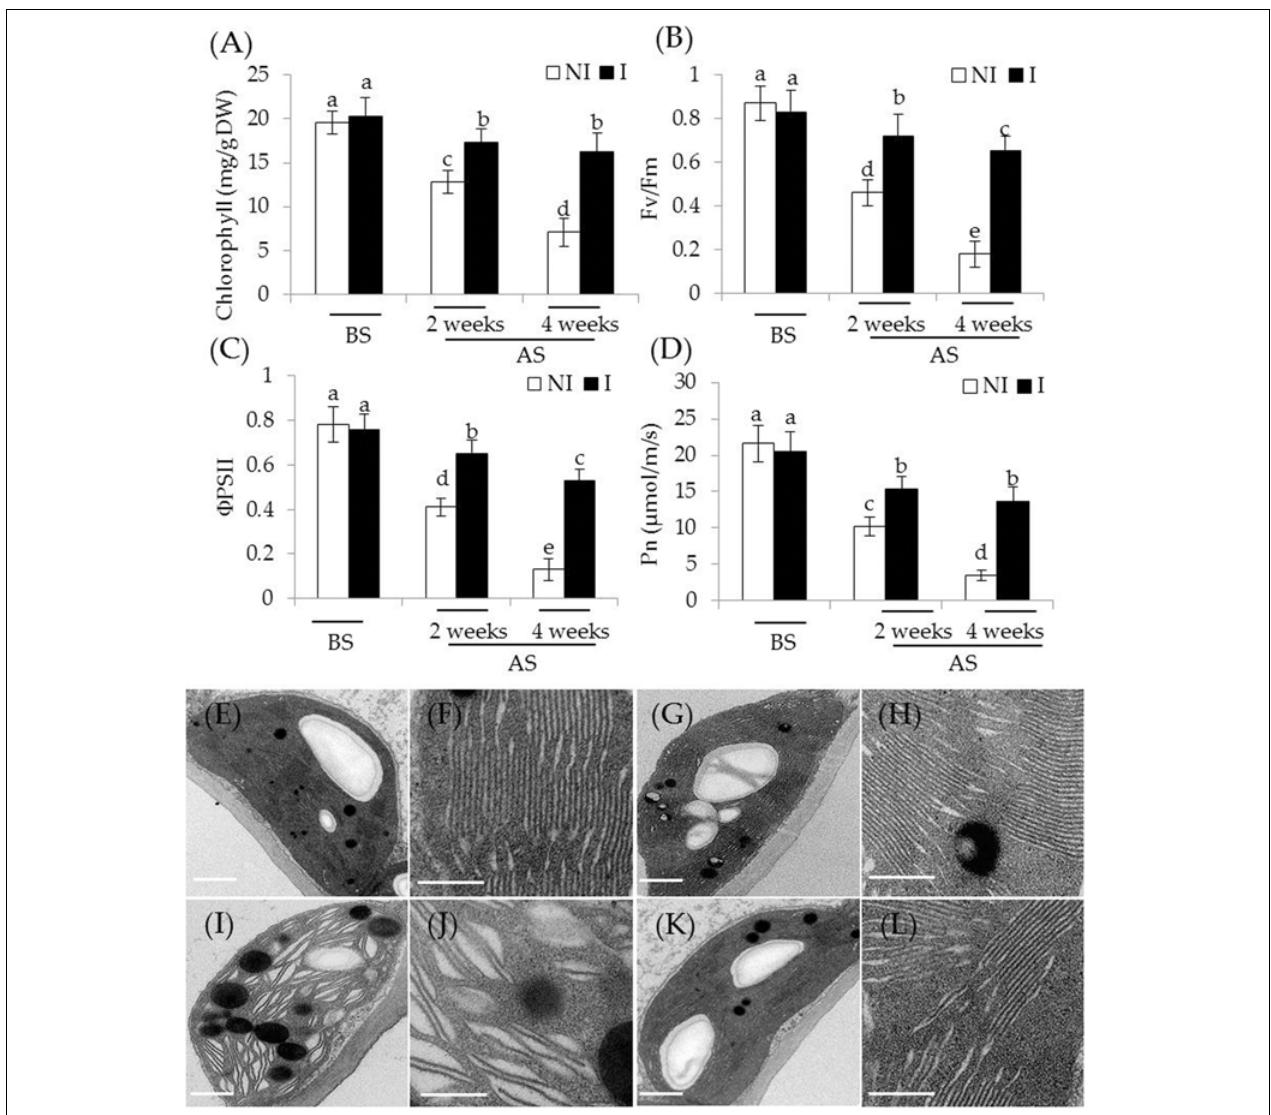
FIGURE 2 | Effects of B. licheniformis SA03 on the photosynthesis of Chrysanthemum plants under saline–alkaline stress. After 10 days of bacterial inoculation, the non-inoculated (NI) and inoculated (I) were subjected to saline–alkaline treatment for 2 and 4 weeks, respectively. The treated plants were used to measure (A) total chlorophyll content; (B) F v/ F m; (C) (cid:56) PSII; and (D) Pn. In addition, transmission electron micrographs of chloroplast ultrastructure in mesophyll cells of plants. Chloroplast ultrastructure of the non-inoculated (E) and inoculated plants (G) before the stress treatment, and (F,H) indicated locally amplified view in (E,G) , respectively. Chloroplast ultrastructure of the non-inoculated (I) and inoculated plants (K) after the stress treatment, and (J,L) indicated locally amplified view in (I,K) , respectively. Scale bar = 1 µ m. BS, before the stress treatment; AS, after the stress treatment. Data are expressed as the mean values of three replicates ( ± SE) with 10 plants each. Different letters indicate significant differences using two-way ANOVA followed by the Duncan’s multiple range test at P <